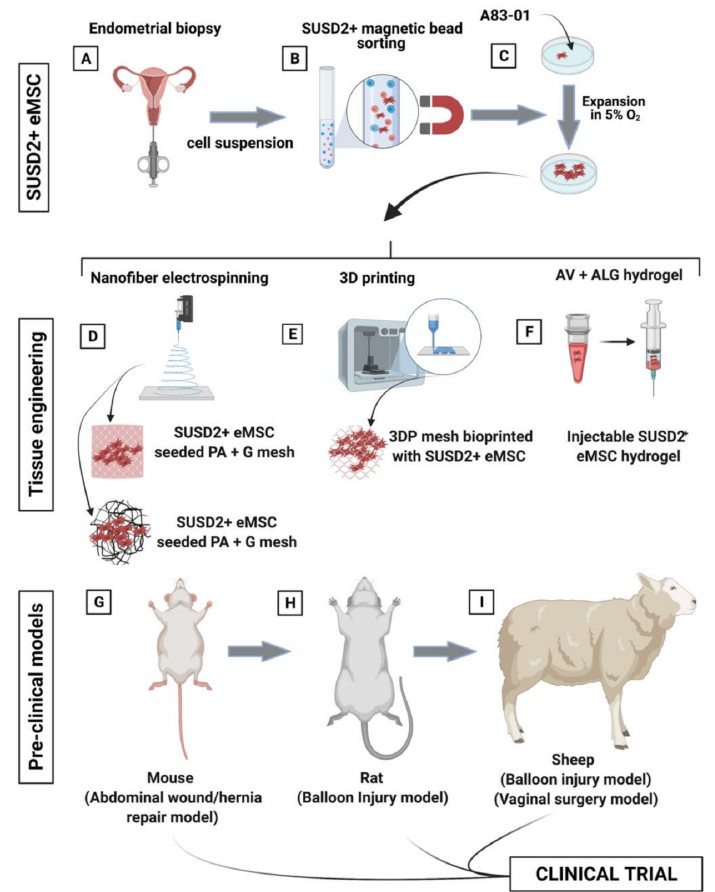
Figure 9. Schematic showing the process of creating tissue engineering constructs comprising eMSC- seeded degradable poly(L-lactic acid)-co-poly(e-caprolactone (PLACL) nanofiber electrospun mesh. ( A ) eMSC are obtained from endometrial biopsy specimens in an office-based procedure, ( B ) purified by SUSD2 magnetic bead sorting; ( C ) and expanded in serum free media containing A83-01 in 5% O 2 . ( D – F ) Generation of biomimetic tissue engineered constructs included nanofiber